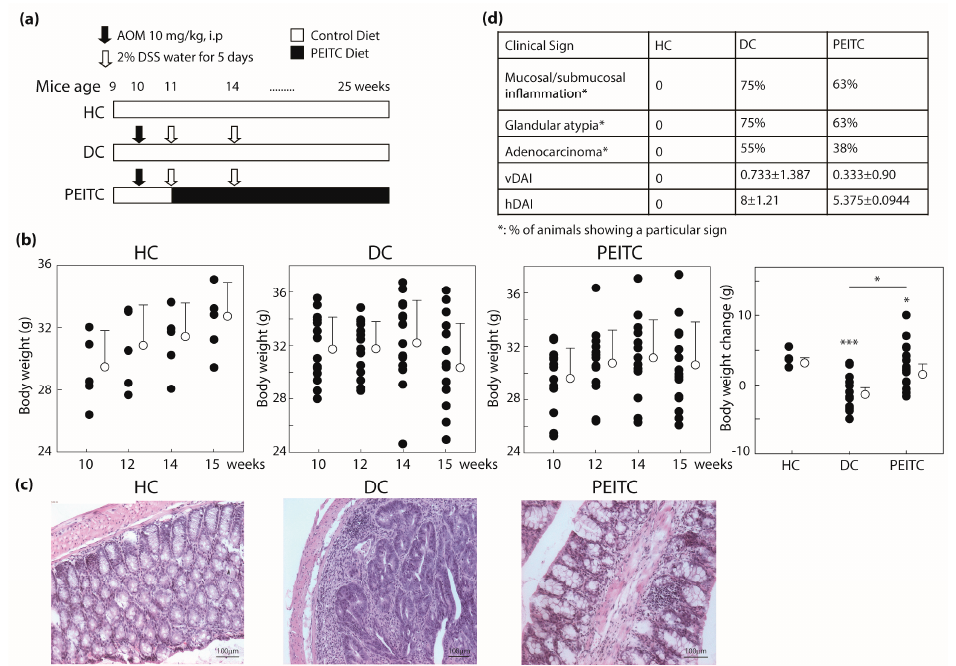
Figure 1. Phenethyl isothiocyanate or PEITC protects experimental mice from AOM/DSS induced colitis associated colon cancer. ( a ) Experimental design; ( b ) Body weights; ( c ) Representative H&E stained colonic sections ( × 100) from each group; ( d ) Table of clinical sign ( a ) In vivo experimental design; ( b ) Body weight changes shown from week 10 to 15 (all panels); ( c ) Representative H&E staining from each experimental mice group showing presence of goblet cells (HC, PEITC groups), absence (HC) or minimal presence (PEITC) of inflammatory cell aggregates, and presence of precancerous and cancerous lesions (DC), scale bars measure 100 µ m; ( d ) Tabular summary of clinical signs. n = 15 (except 5 for HC), * p < 0.05, *** p < 0.001. PEITC, phenethyl isothiocyanate; HC, healthy